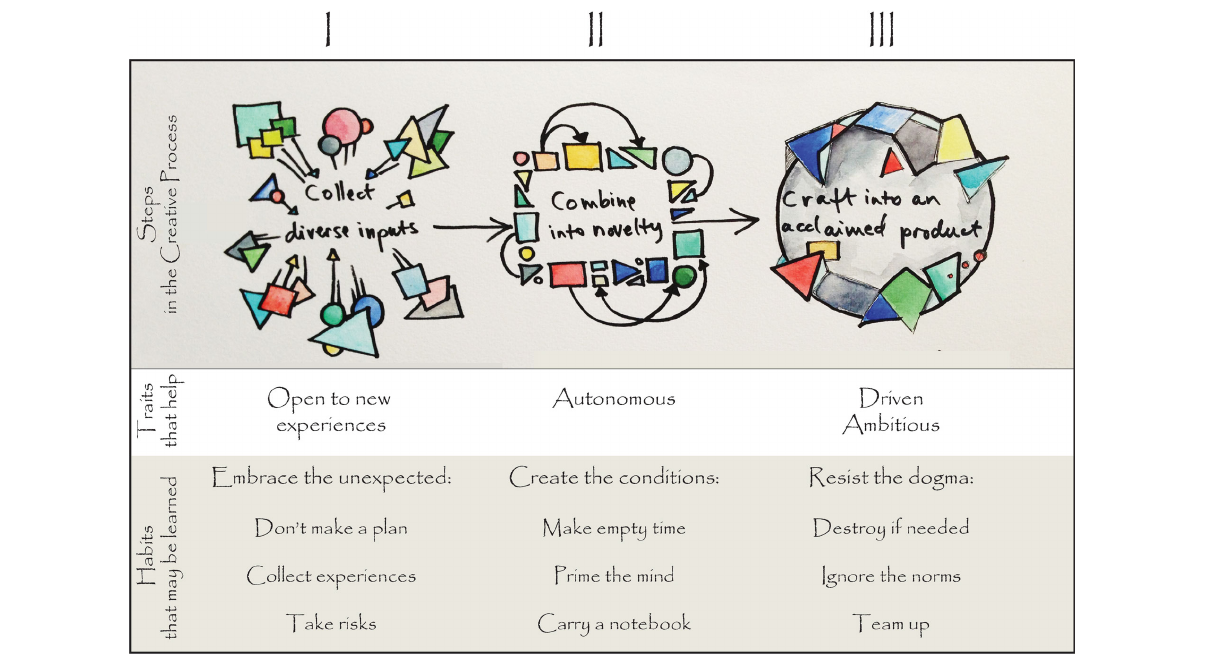
Fig. 1. Three steps in the creative process that are facilitated by distinct character traits, which are relatively difficult to change, but also by sets of practical habits that may be easier to